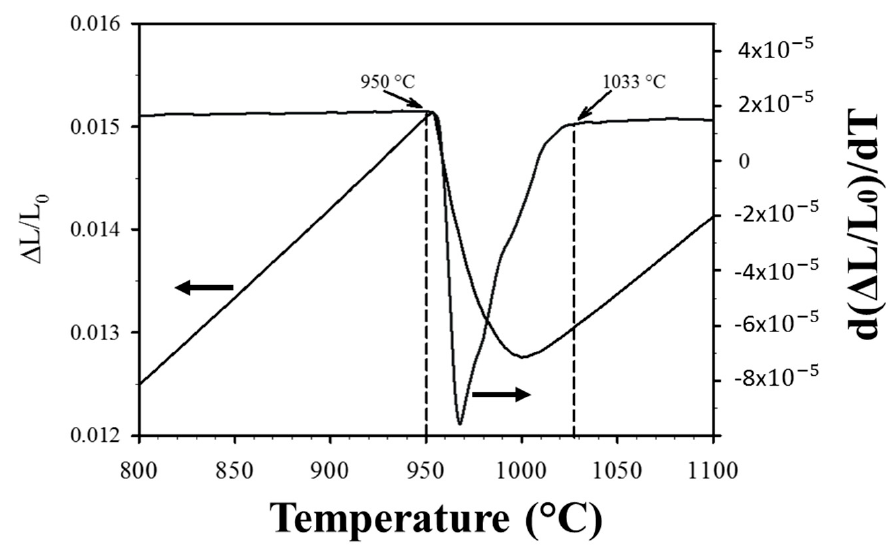
Figure 3. Dilatometry curve for the hot-rolled steel obtained during heating at 0.025 °C/s.